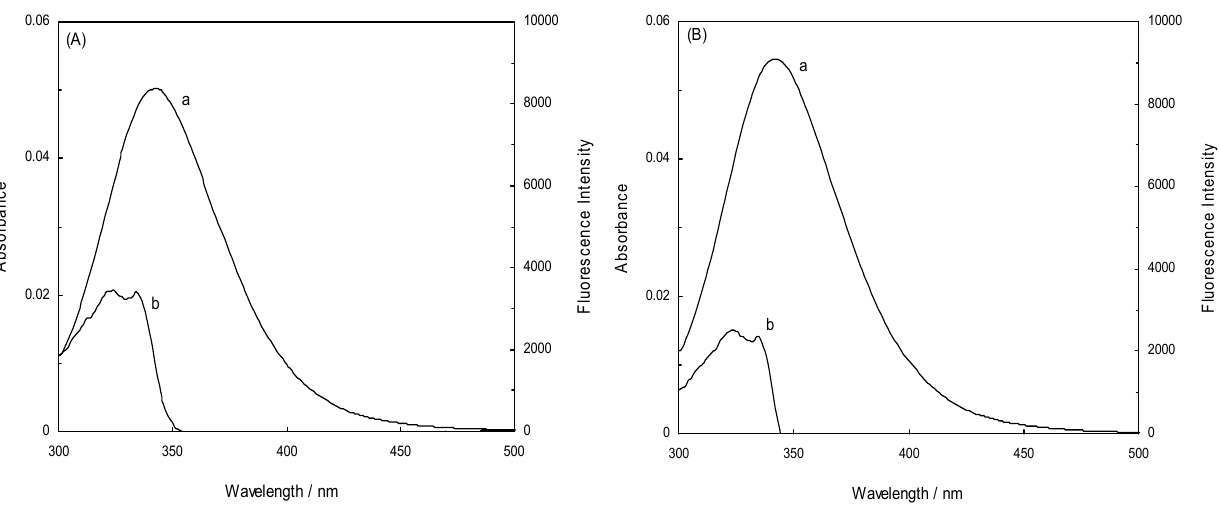
Figure 8. Spectral overlap of the fluorescence spectra (curves a) of HSA-NRF ( A ) and HSA-NRF at 1 MHz/59 μ T ( B ) with the absorption spectrum (curves b) of NRF.